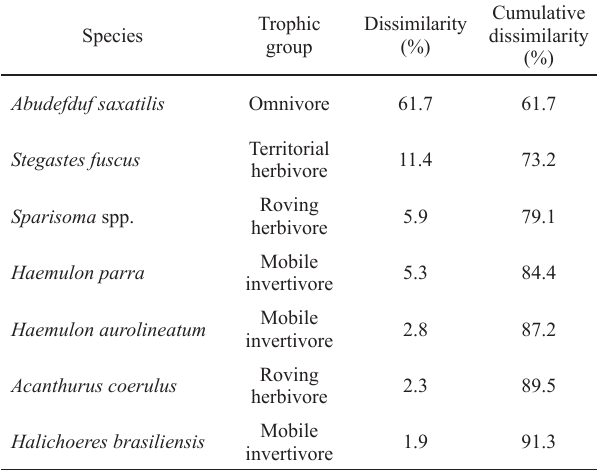
Table 4. Differences in number of species and abundance (me- dian of the number of individuals ± SD) per census of the eight trophic groups between periods with the presence of tourists (PT) and absence of tourists (AT). Statistical significance: p <